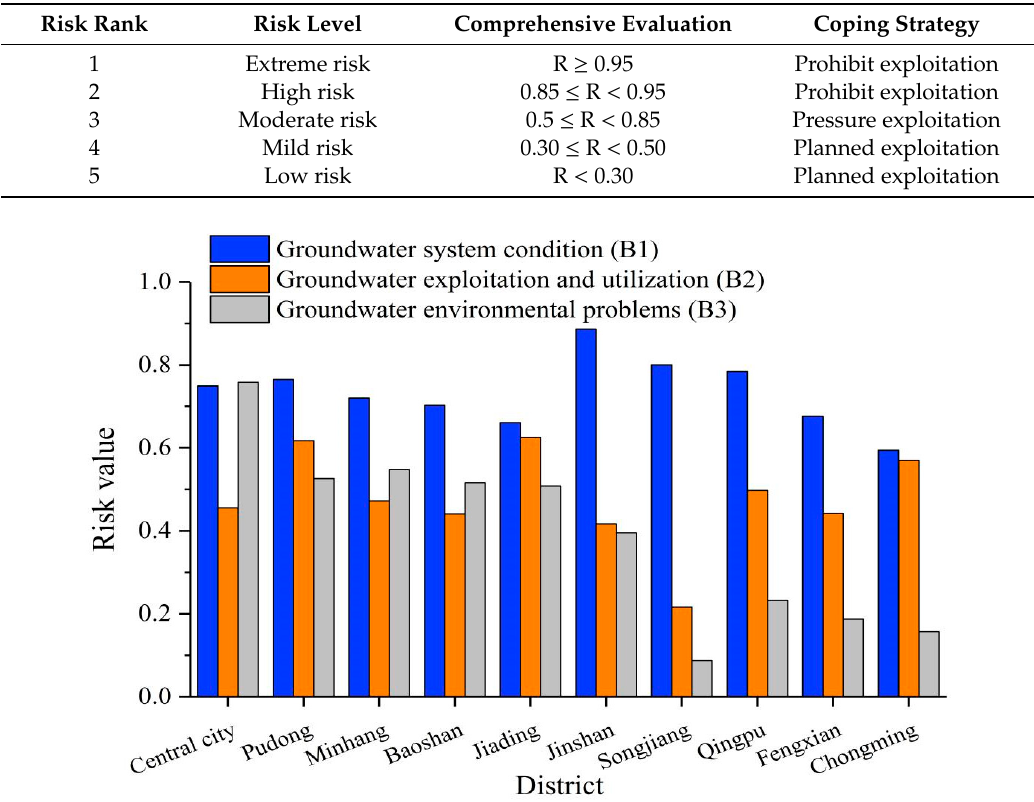
Table 10. Classification criteria for groundwater exploitation and utilization risk.